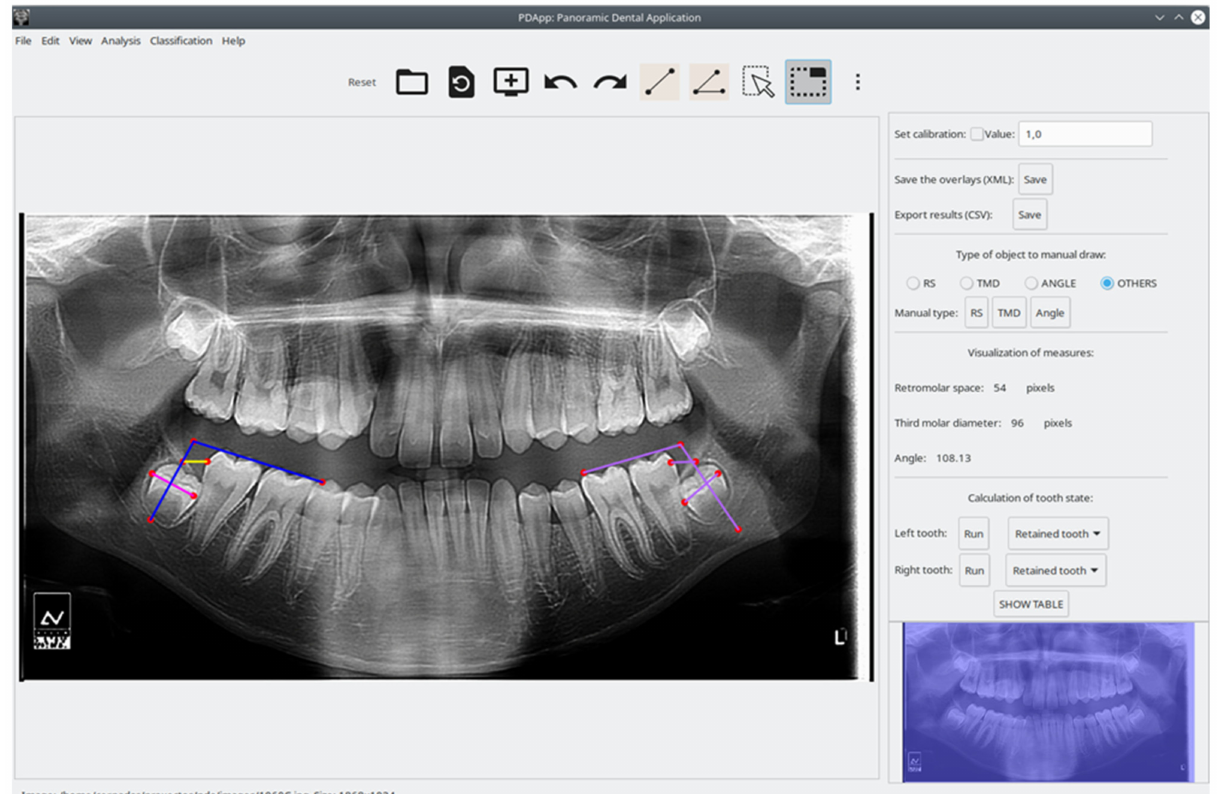
Figure 1. Screenshot of PDApp v.1 software with analysis of typical panoramic radiograph and lateral panel open. In the right molar, the pink line represents third molar diameter, the yellow line represents retromolar space, and blue lines represent the angle. Measurement of the left molar (violet objects) are shown in the lateral